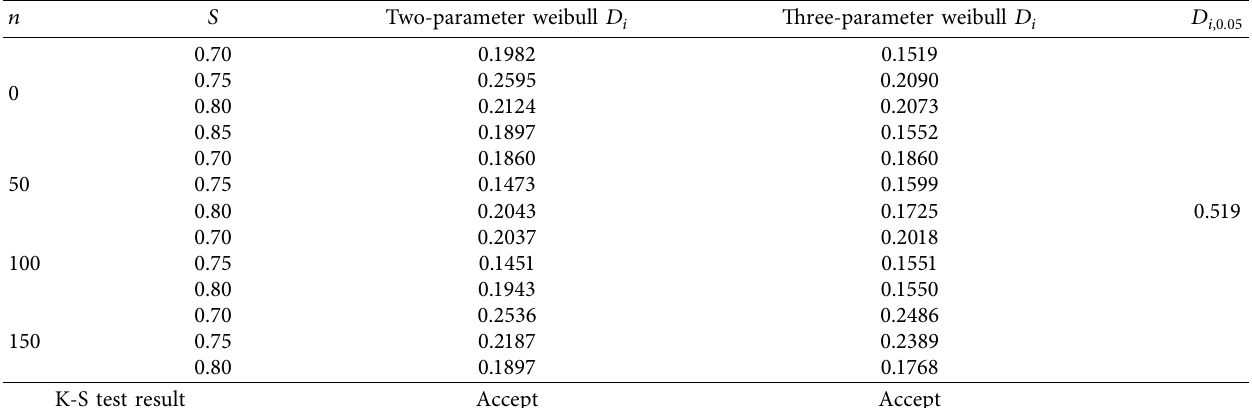
Table 10: Two-parameter and three-parameter Weibull distributions tests of the fatigue life of AASC.